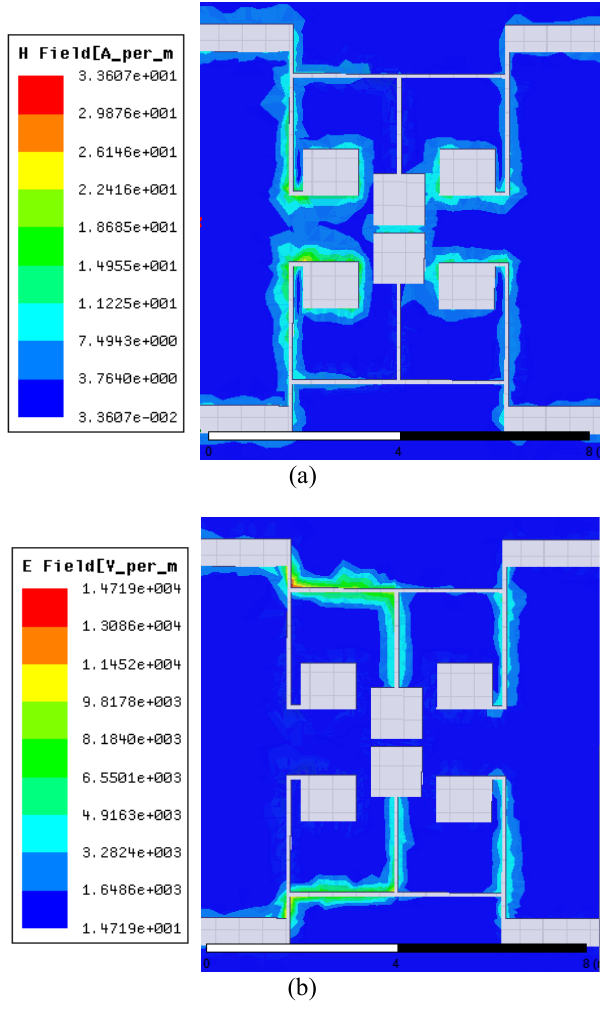
Figure 8: Field distributions of the proposed LUC (a) electric field (b) magnetic field.